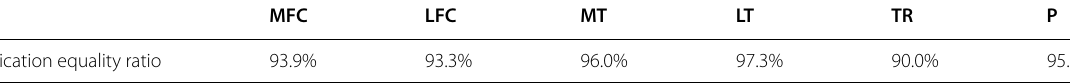
Table 6 The ratio of the equality of operative indication in 6 recipient sites